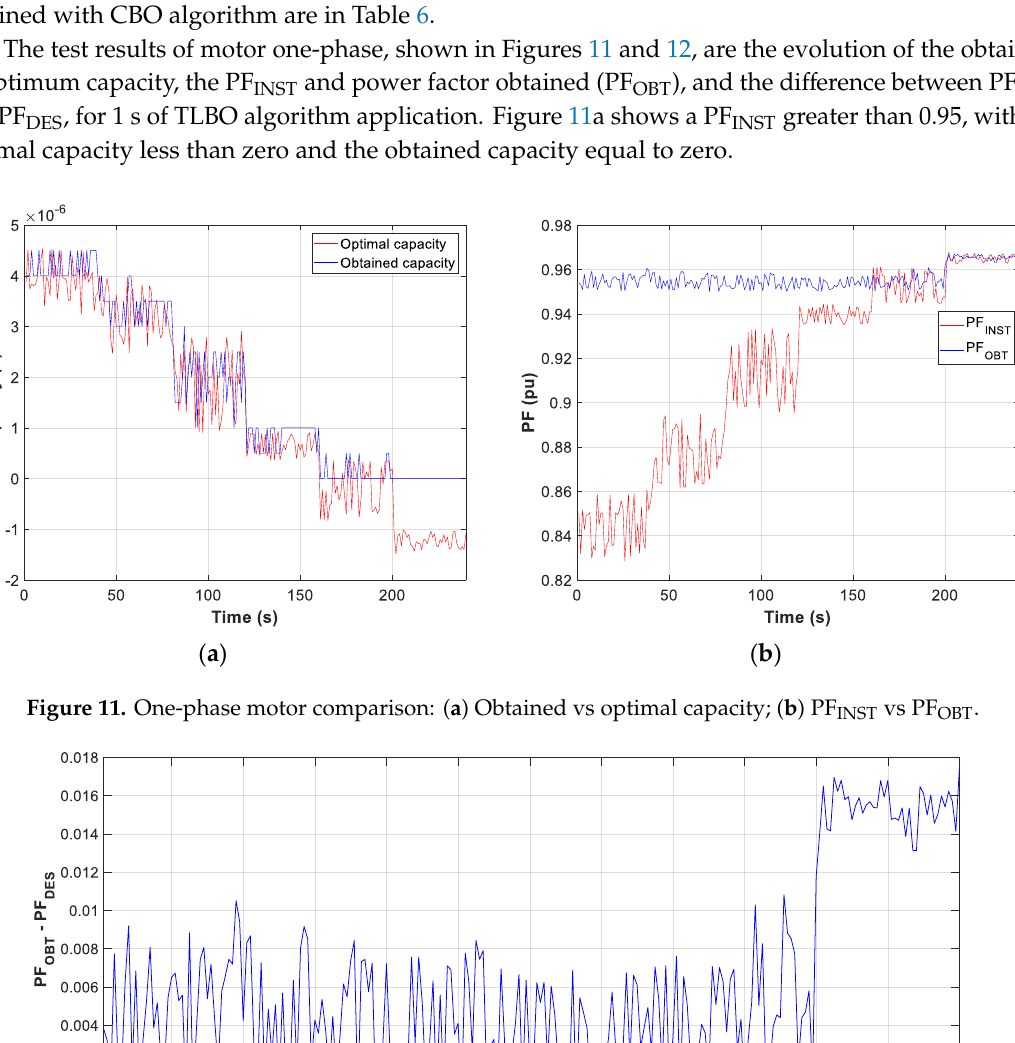
Figure 12. Difference between PF OBT and PF DES (1-phase motor).